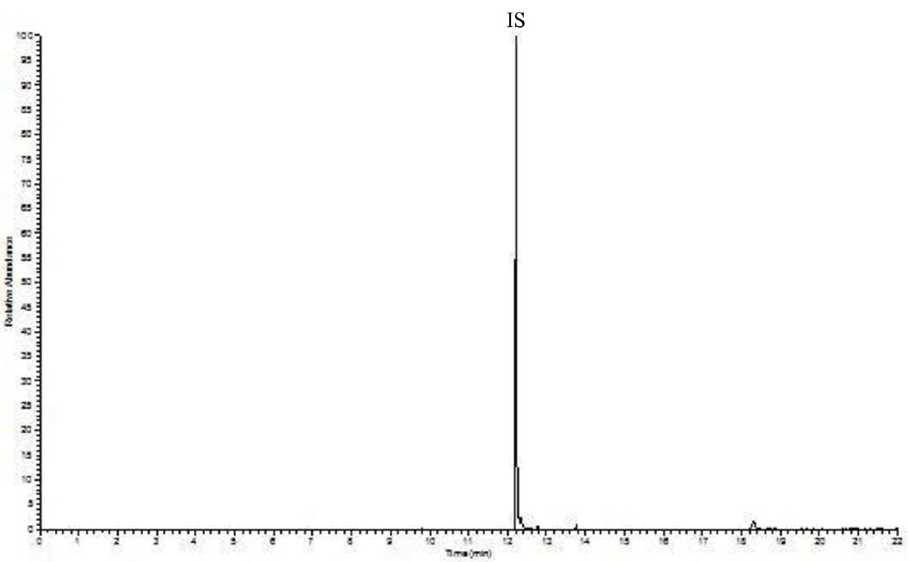
Figure 1. Blank chromatogram evidencing the absence of any PAE contamination in the lab glassware/reagents. The graph reported the relative abundance (y axis ) as function of the time in min (x axis ). For experimental conditions: see text.